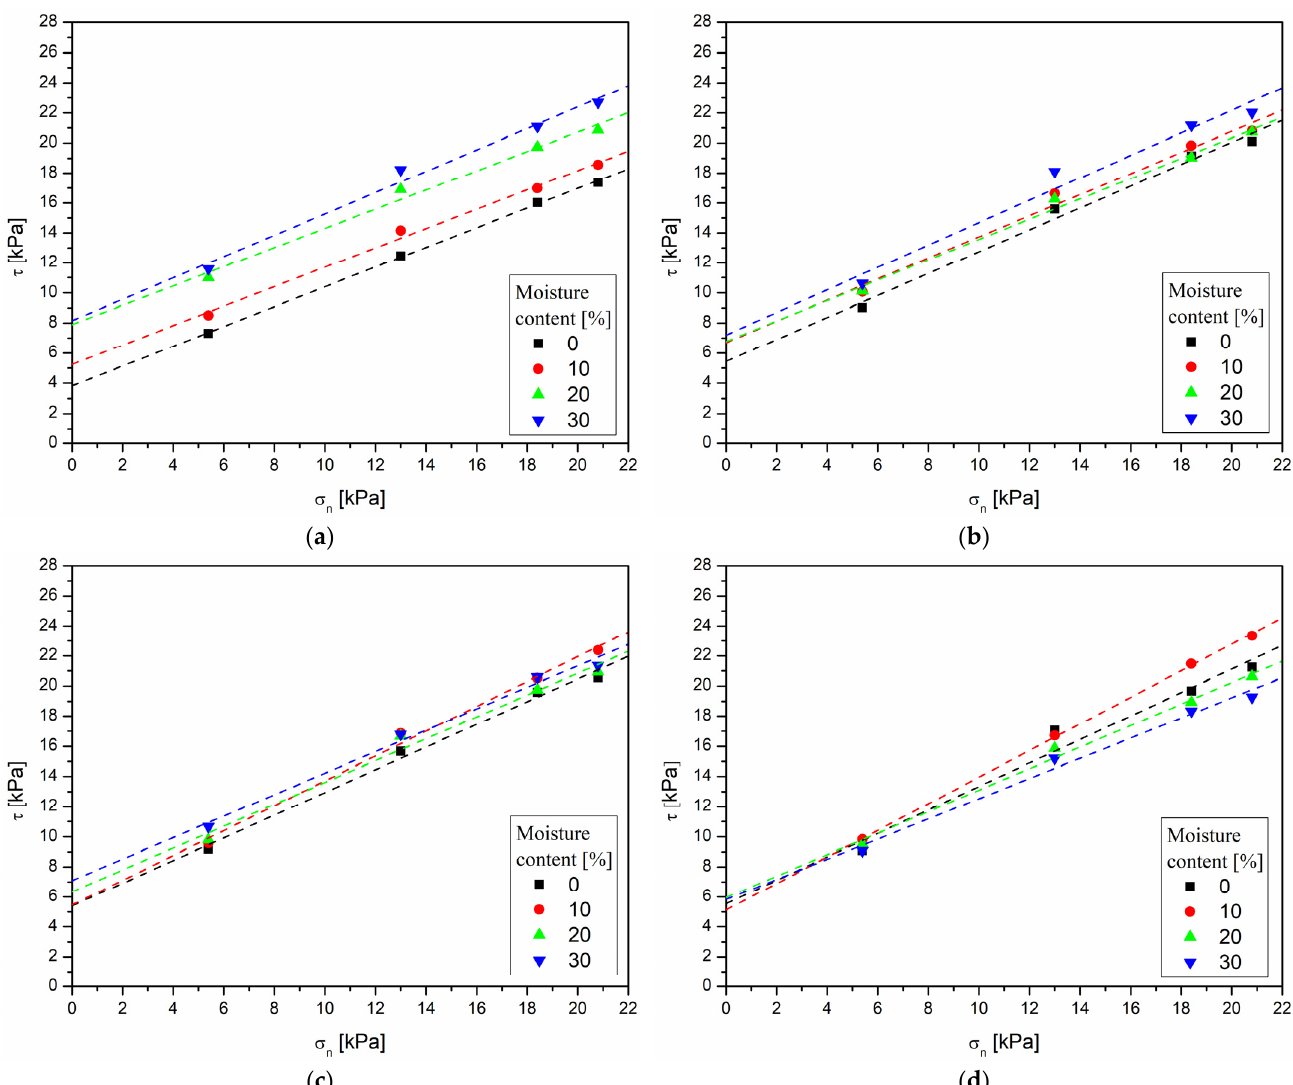
Figure 8. Effect of moisture content on yield loci for: ( a ) mixture of HC 95%, MBM 5%; ( b ) mixture of HC 70%, MBM 30%; ( c ) mixture of HC 40%, MBM 60%; ( d ) MBM. HC 70%, MBM 30%; ( c ) mixture of HC 40%, MBM 60%; ( d )